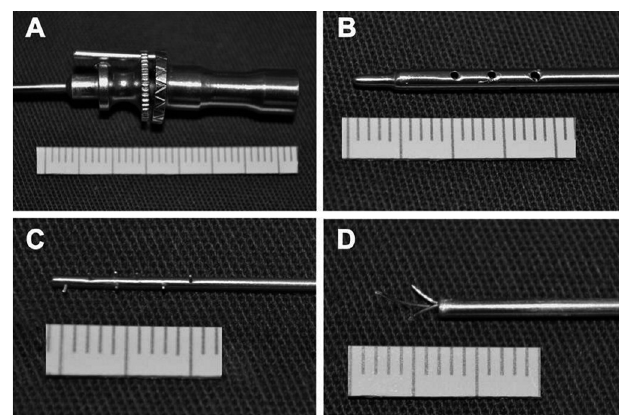
Fig. 2 – Photo presentation. A: Locking mechanism; B: External needle with blunt tip, with multiple 0.5 mm diameter holes. C: Brush- mandrill; D: Self-expandable feather shaped